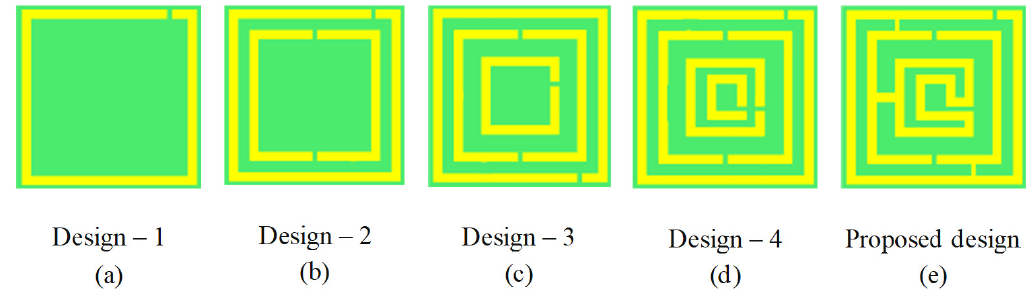
Figure 2. Design evolution of metamaterial unit cell.